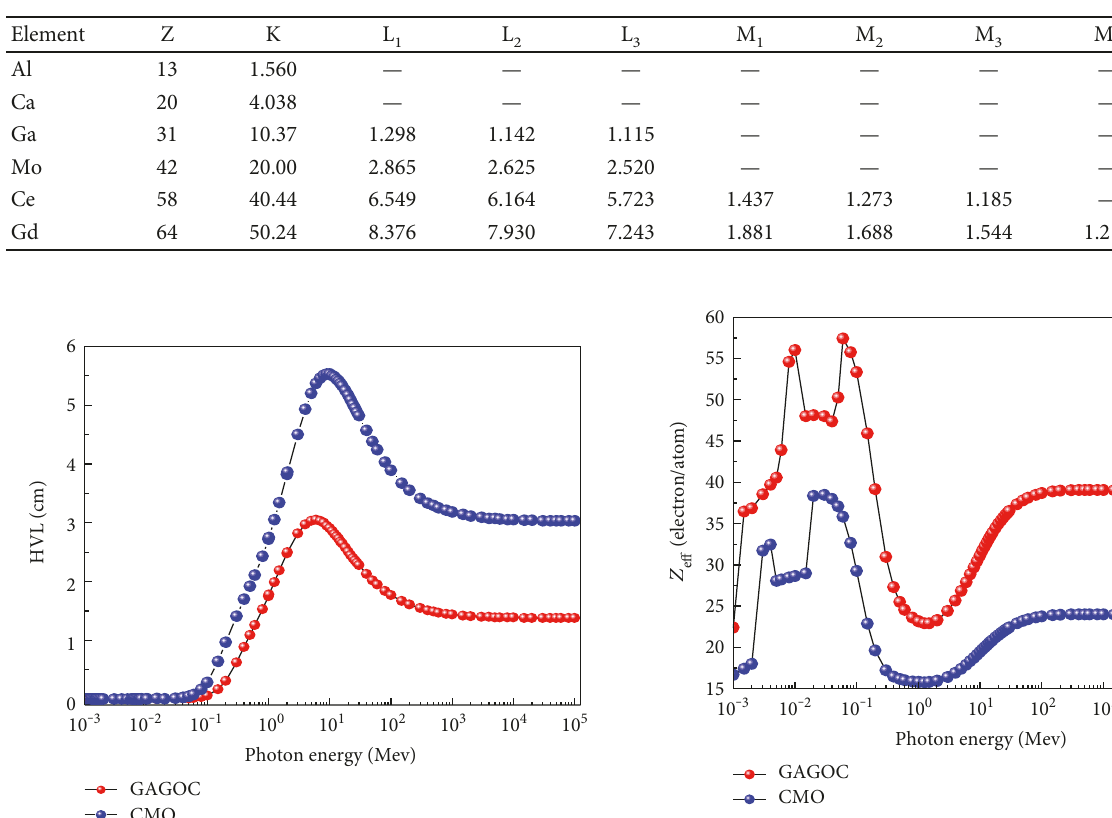
Table 1: K-, L-, and M-absorption edges (keV) for elements.